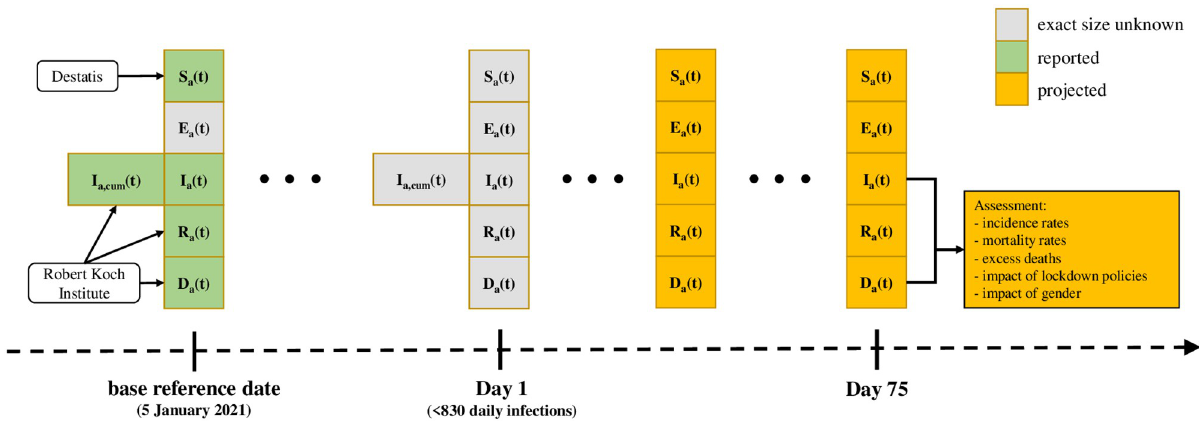
Fig 5. Diagram of the scenario analysis approach. Outline of the scenario analysis. For every compartment C , C from group a which are in compartment C at time t ; I a ,cum denotes cumulative number of infections. S a ( t ) on the base reference date are obtained from Destatis (Federal Statistical Office of Germany); I